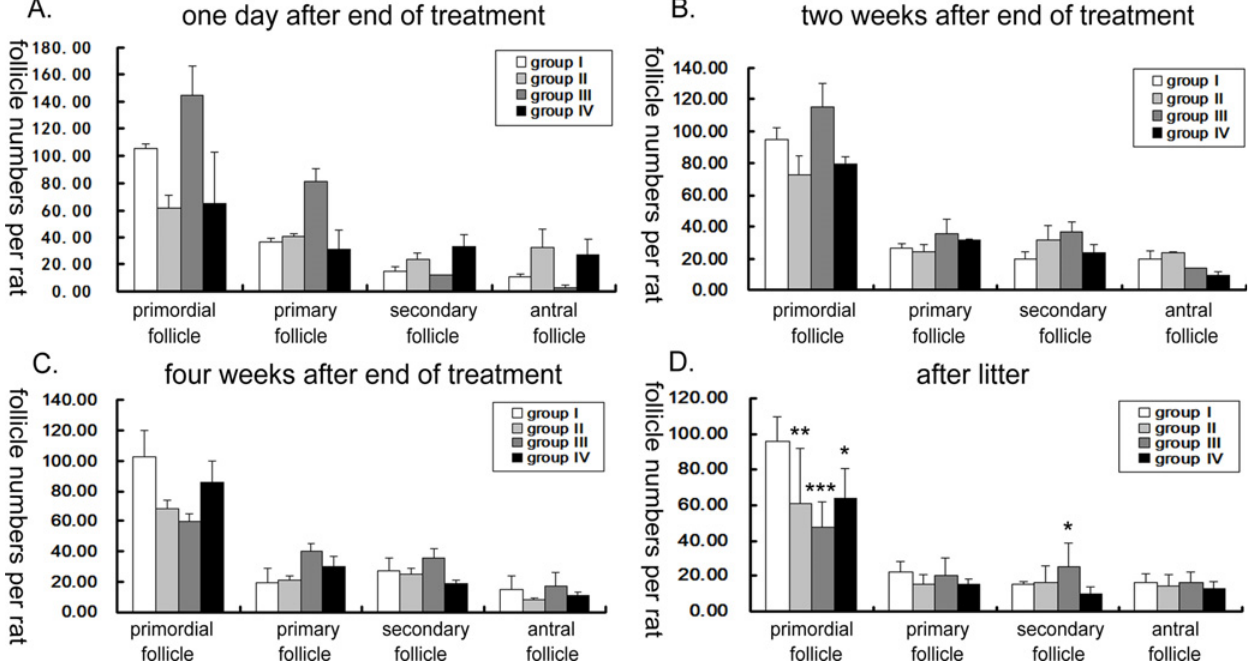
Fig 4. Follicle count at different time points. Morphologically normal follicles in the different stages of development were compared between different groups at: (A) one day after end of treatment, (B) two weeks after end of treatment, (C) four weeks after end of treatment, (D) after litter. * p < 0.05, ** p < 0.01, *** p < 0.001.